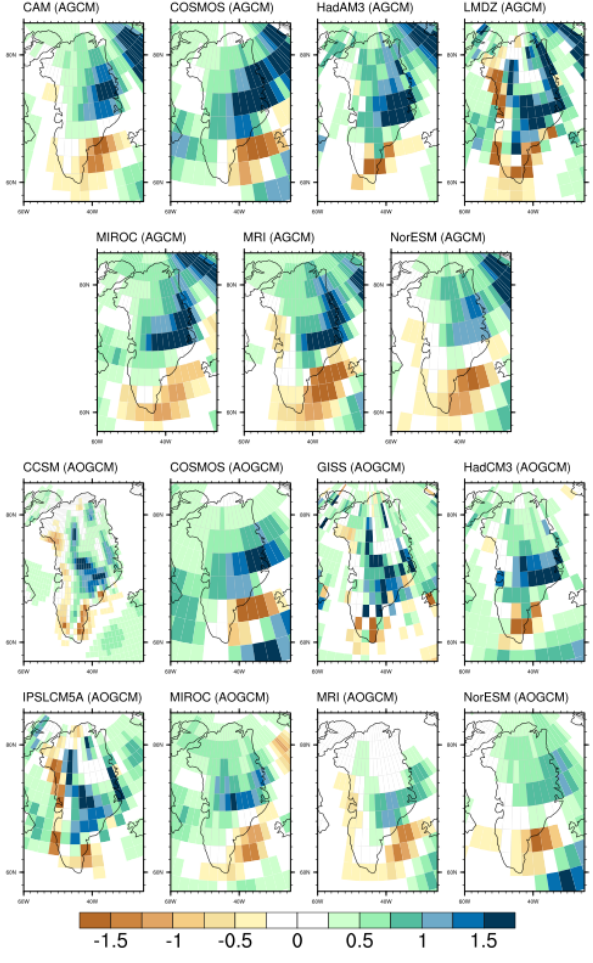
Figure 3. mPWP minus pre-industrial mean annual precipita- tion (mmday − 1 ) over Greenland for the PlioMIP ensemble using atmosphere-only (AGCMs) and coupled atmosphere–ocean climate models (AOGCMs). Precipitation plotted on the original climate model resolution.